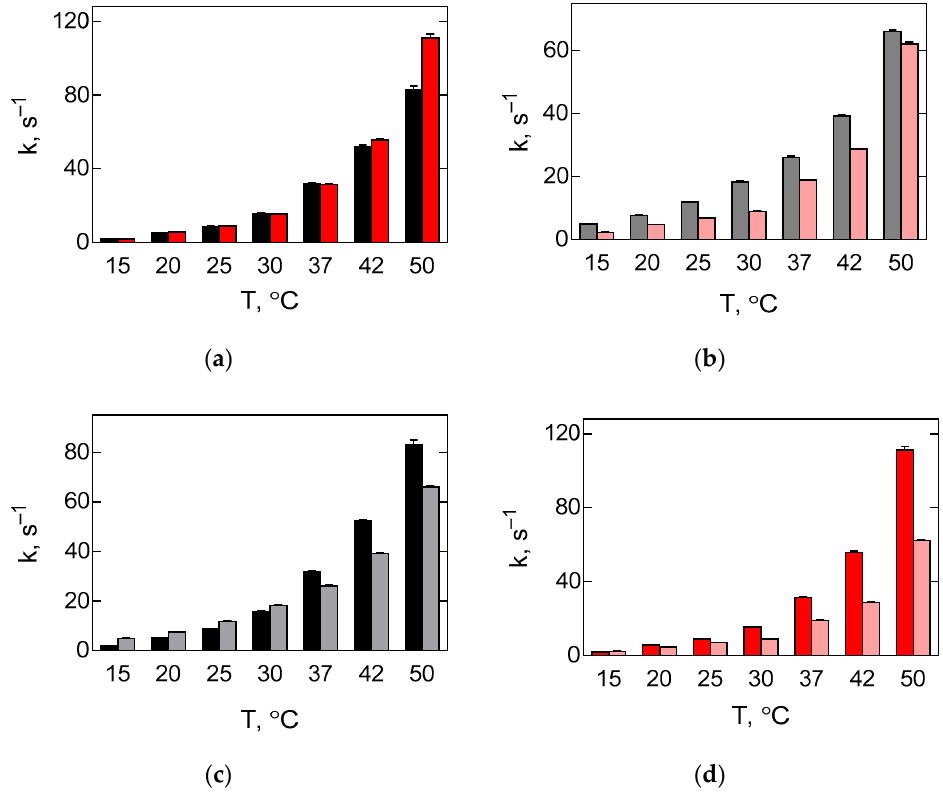
Figure 4. Comparative analysis of temperature dependence of translocation catalysed by EF-G from E. coli or T. thermophilus . Bar graphs showing rates of translocation (k 1 of double-exponential fit, Figure 3 and Table 1). Error bars correspond to respective s.e.m. ( a ) Rate of translocation induced by EF-G from E. coli (black) or T. thermophilus (red) and detected by the label at the elbow region of tRNA. ( b ) Rate of translocation induced by EF-G from E. coli (grey) or T. thermophilus (pink) and detected by the label at CCA-end of tRNA. ( c ) Rate of translocation induced by EF-G from E. coli and detected by the label at the elbow region (black) and CCA-end (grey) of tRNA. ( d ) Rate of translocation induced by EF-G from T. thermophilus and detected by the label at the elbow region (red) and CCA-end (pink) of